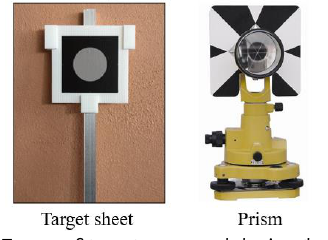
Figure 21. Types of target scan used during the scanning process